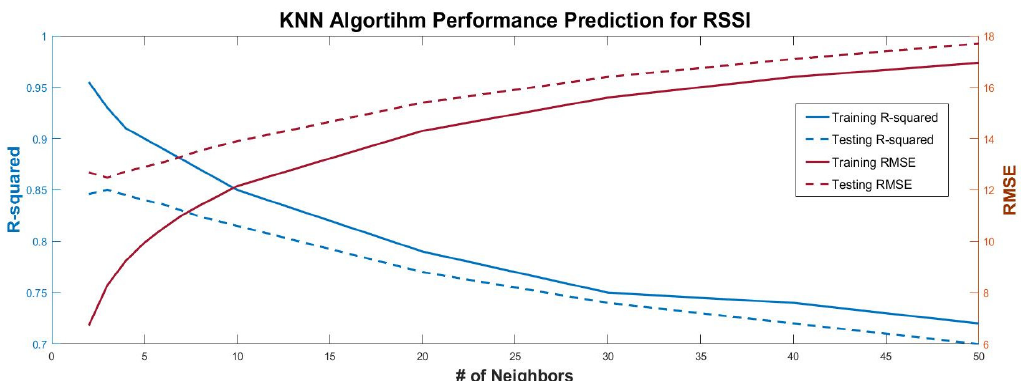
Figure 4. Performance metrics plot for KNN algorithm against different number of neighbors.